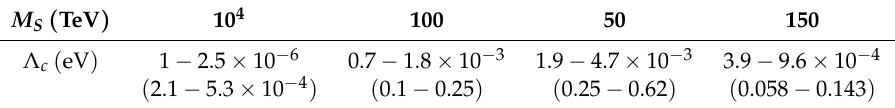
Table 1. The values of Λ c for α 3 ( M Z ) = 0.115–0.121, M t = 171–176 GeV, and different SUSY breaking scales M S in the physical vacuum. These values are calculated in the two-loop approximation using matching Conditions (32)–(33). The values of Λ c computed in the one-loop approximation are given in the